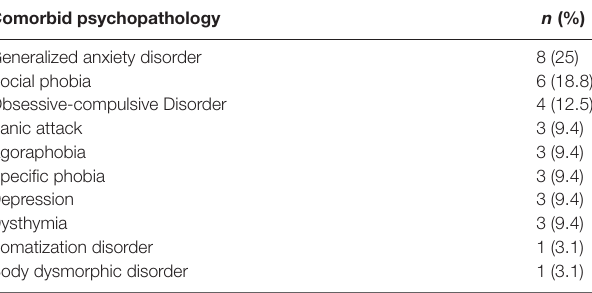
CHR, clinical high risk.